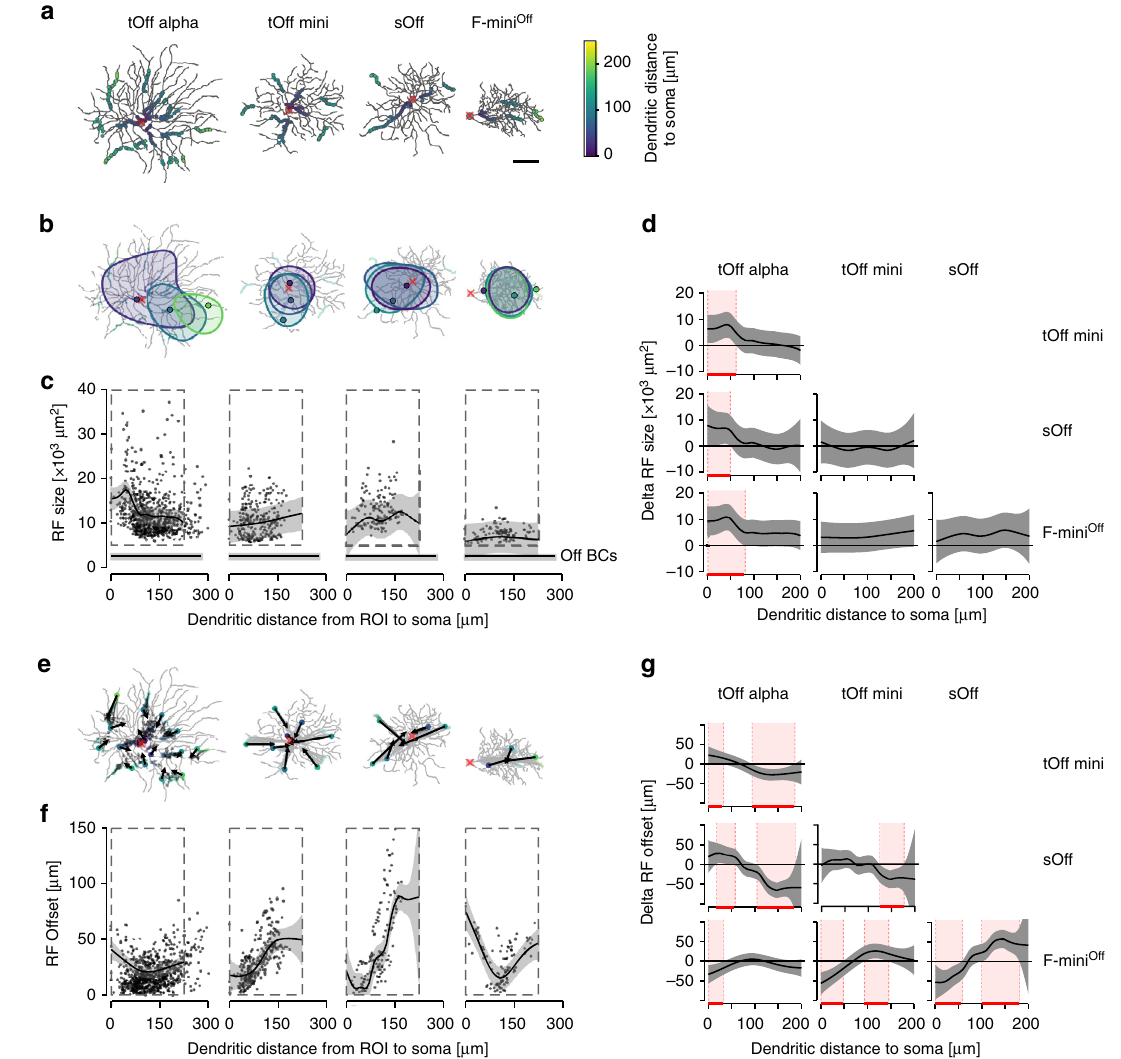
Fig. 3 Local dendritic RF area and position varies in different RGC types. a Top-views of the different reconstructed RGC types, overlaid with ROIs that passed the RF quality test. ROI colours indicate dendritic distance to soma. b Cells from a with three ROIs of increasing distance from soma and corresponding RF contours overlaid (red cross indicates soma position). c Dendritic RF area as a function of dendritic distance to soma; data pooled across cells of the same type (see below). Horizontal black line marks mean RF size of Off BCs with s.d. shading in grey (2360 ± 1180 µ m 2 , n = 4242 ROIs; data from (ref. 37 )). d Comparison of RF area change with dendritic distance to soma for data marked by the dashed rectangles in c between each pair of RGC type. Red shaded areas indicate dendritic sections with signi fi cant differences between types (Methods). e Cells from a with arrows indicating spatial offset between ROI centre and the RF contour ’ s geometrical centre, with arrows pointing at the latter. f RF offset of all recorded ROIs as a function of dendritic distance to soma. g Like d but for RF offset changes for data points inside the dashed rectangles in f . Data from tOff alpha ( n = 17\1452\850 cells\total ROIs\ROIs passing the quality test), tOff mini ( n = 5\387\295), sOff ( n = 4\208\154) and F-mini Off RGCs ( n = 5\265\126); for individual cell morphologies, see Supplementary Fig. 4. Scale bar: a 50 µ m. For details, see Supplementary Statistical